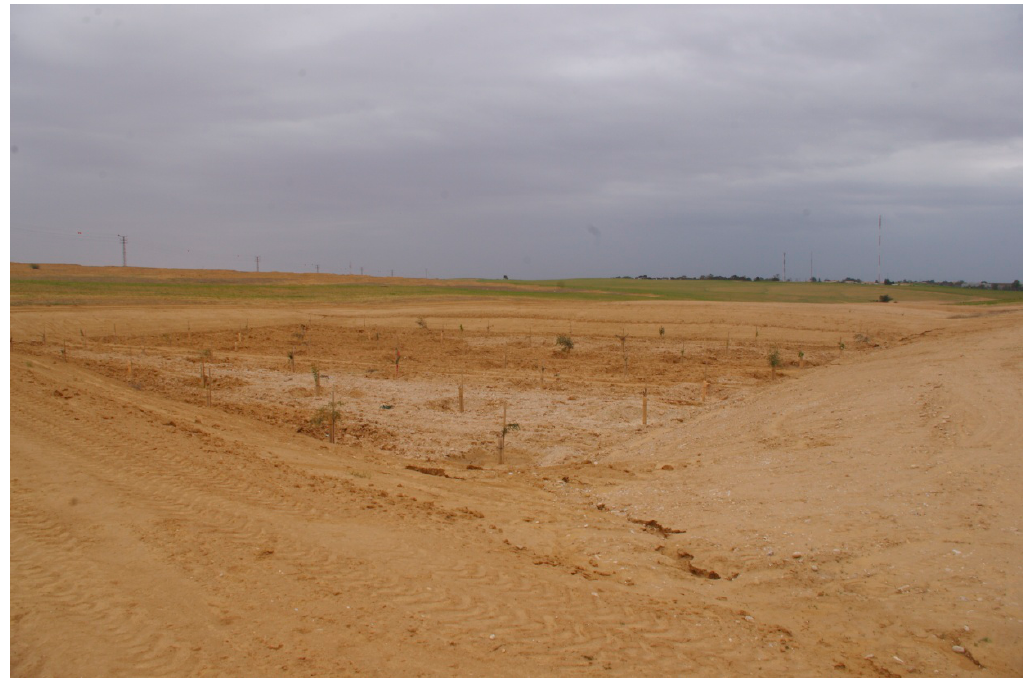
Figure 2. One-year-old liman forestry system in the Israeli semi-arid northern Negev. Note the extensive area from which the topsoil was removed to construct the liman’s dykes. Photo taken by I. Stavi in winter 2018/19.